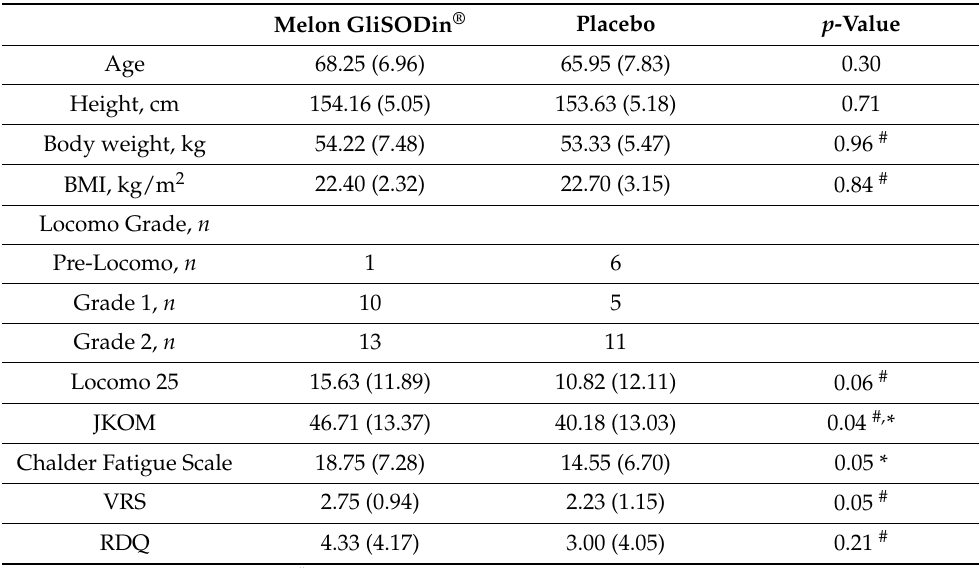
Table 1. Study participants’ baseline characteristics in the Melon GliSODin ® ( n = 24) and placebo ( n = 22) groups.